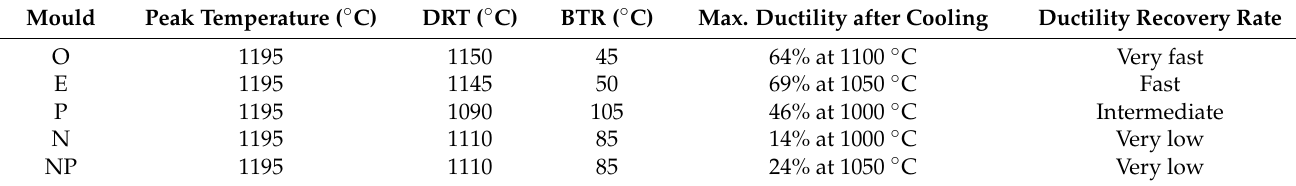
Table 6. Weldability parameters obtained from hot ductility tests.